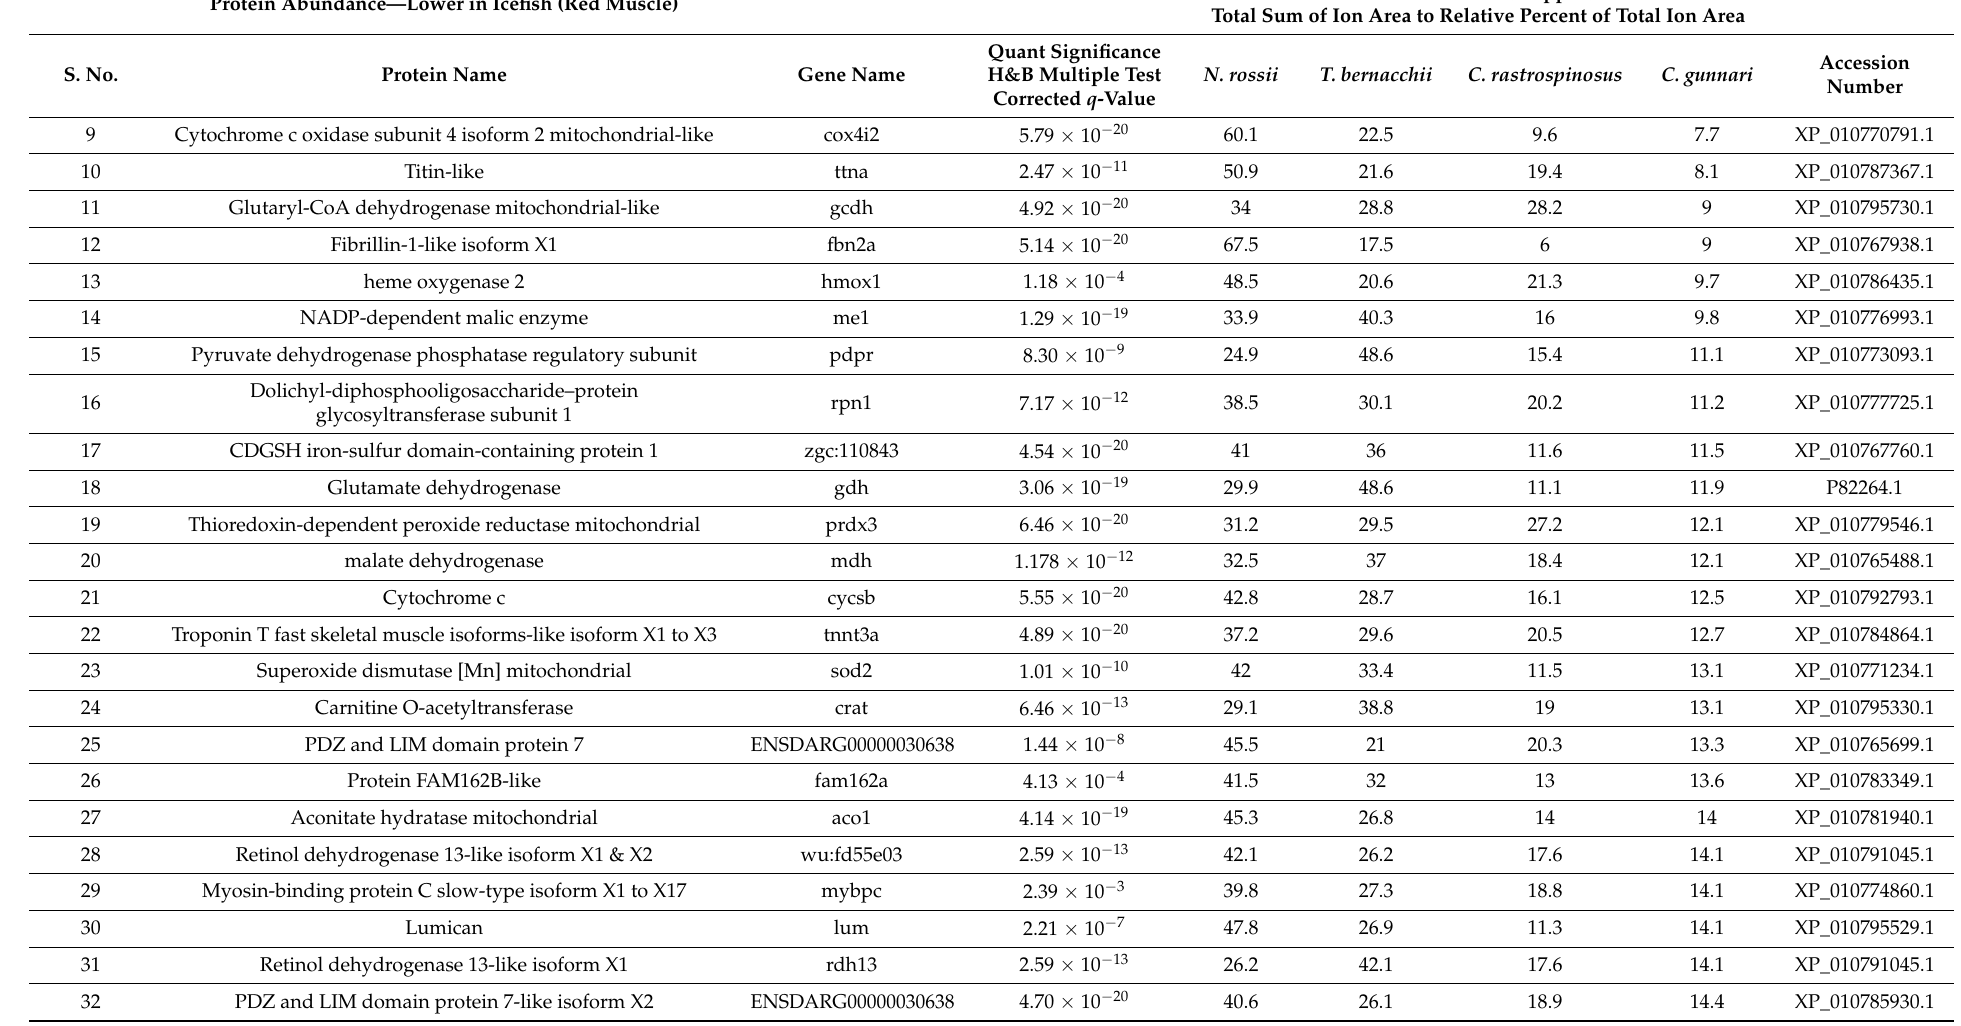
Protein Abundance—Lower in Icefish (Red